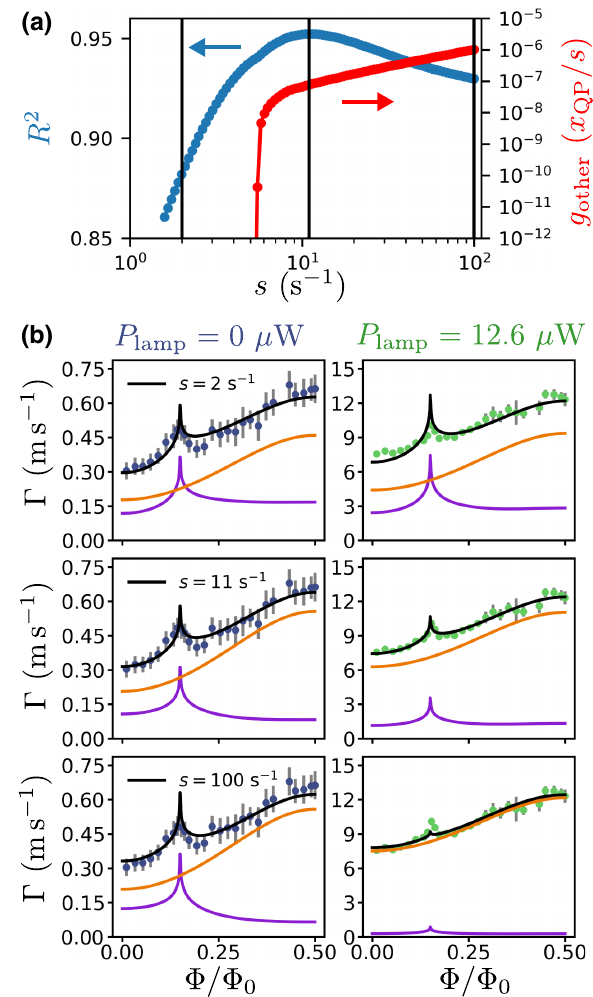
FIG. 14. (a) The pseudo- R 2 goodness-of-fit metric for fits to the full data set as a function of the trapping rate s (blue, left axis). The value of g other obtained in each fit is also plotted for reference (red, right axis). The vertical black lines indicate values of s for which the fits are shown in (b). (b) Fits to the P lamp = 0 μ W (left) and P lamp = 12.6 μ W (right) data for the values of s marked by vertical lines in (a). The fits corresponding to lower values of R 2 (i.e., s = 2 s − 1 and s = 100 s − 1 ) appear to describe the intermediate peak at (cid:5)/(cid:5) 0 = 0.145 less well for the P lamp = 12.6 μ W as compared to the best fit ( s = 11 s − 1